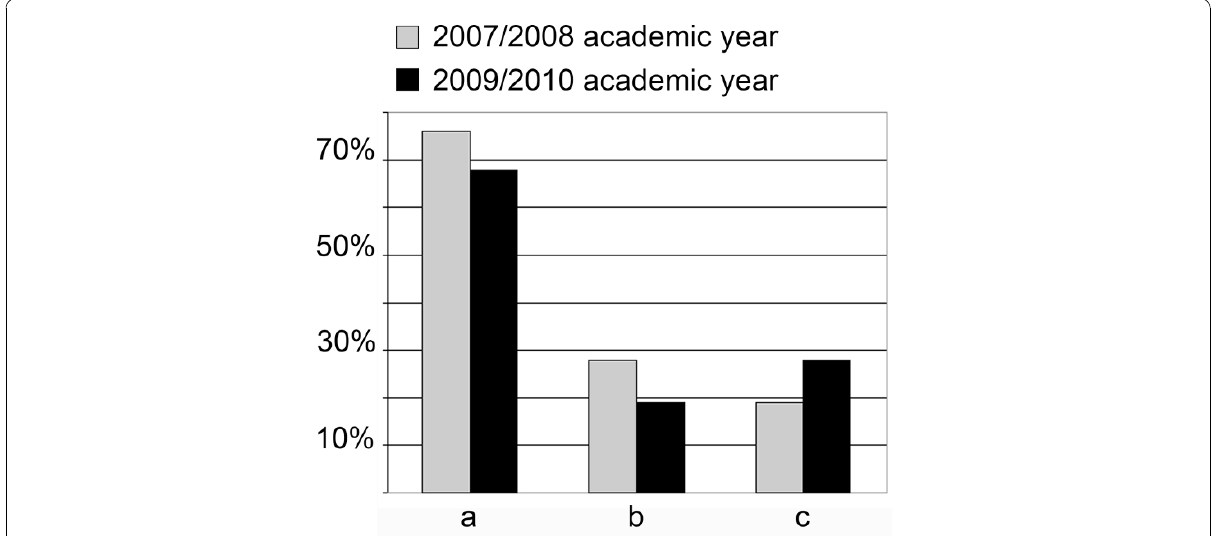
Figure 4 Student activity index . a- Are you disconnecting the consultation in order to browse the slide for yourself? b- Are you requesting the control of the consultation? c- Are you taking pictures from the slides for your